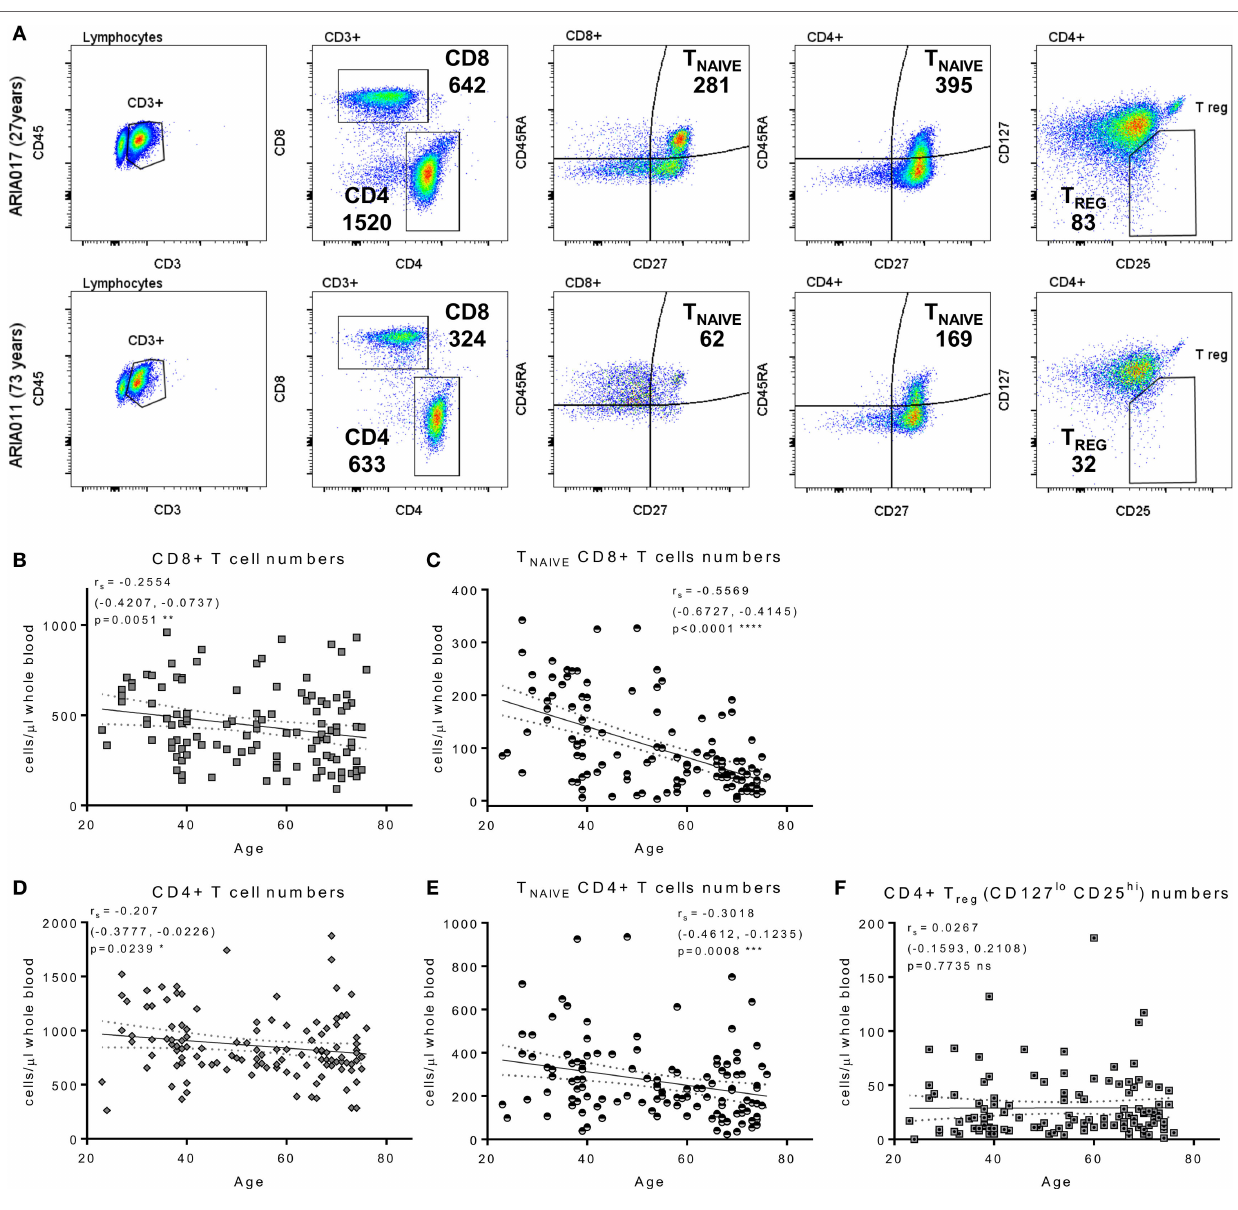
FigUre 1 | Impact of aging on T cell numbers. EDTA treated whole blood was stained with a panel of phenotyping antibodies in order to enumerate CD4 + and CD8 + T cells and their subsets. Representative dot plots from a young and old donor showing CD4 + and CD8 + T cell gates, naïve T cells subset were defined by CD27 + and CD45RA + (T NAIVE ) expression, and CD4 + T regulatory cells (T reg —CD25 hi , CD127 lo ); the number of cells per microliter of whole blood present for each gated population of interest are also indicated (a) . Graphs illustrating the numbers of total CD8 + T cells (B) , T NAIVE CD8 + T cells (c) , total CD4 + T cells (D) , T NAIVE CD4 + T cells (e) , and CD4 + T reg cells (F) of the entire ARIA cohort ( n = 119) correlated to donor age. The relationship of T cell subset numbers with donor age was analyzed using Spearman rank correlation with the results indicated on each graph [r s (95% confidence interval) and p value]. There was a significant decrease in total and T NAIVE CD4 + and CD8 + T cells with age, CD4 + T reg numbers showed no significant